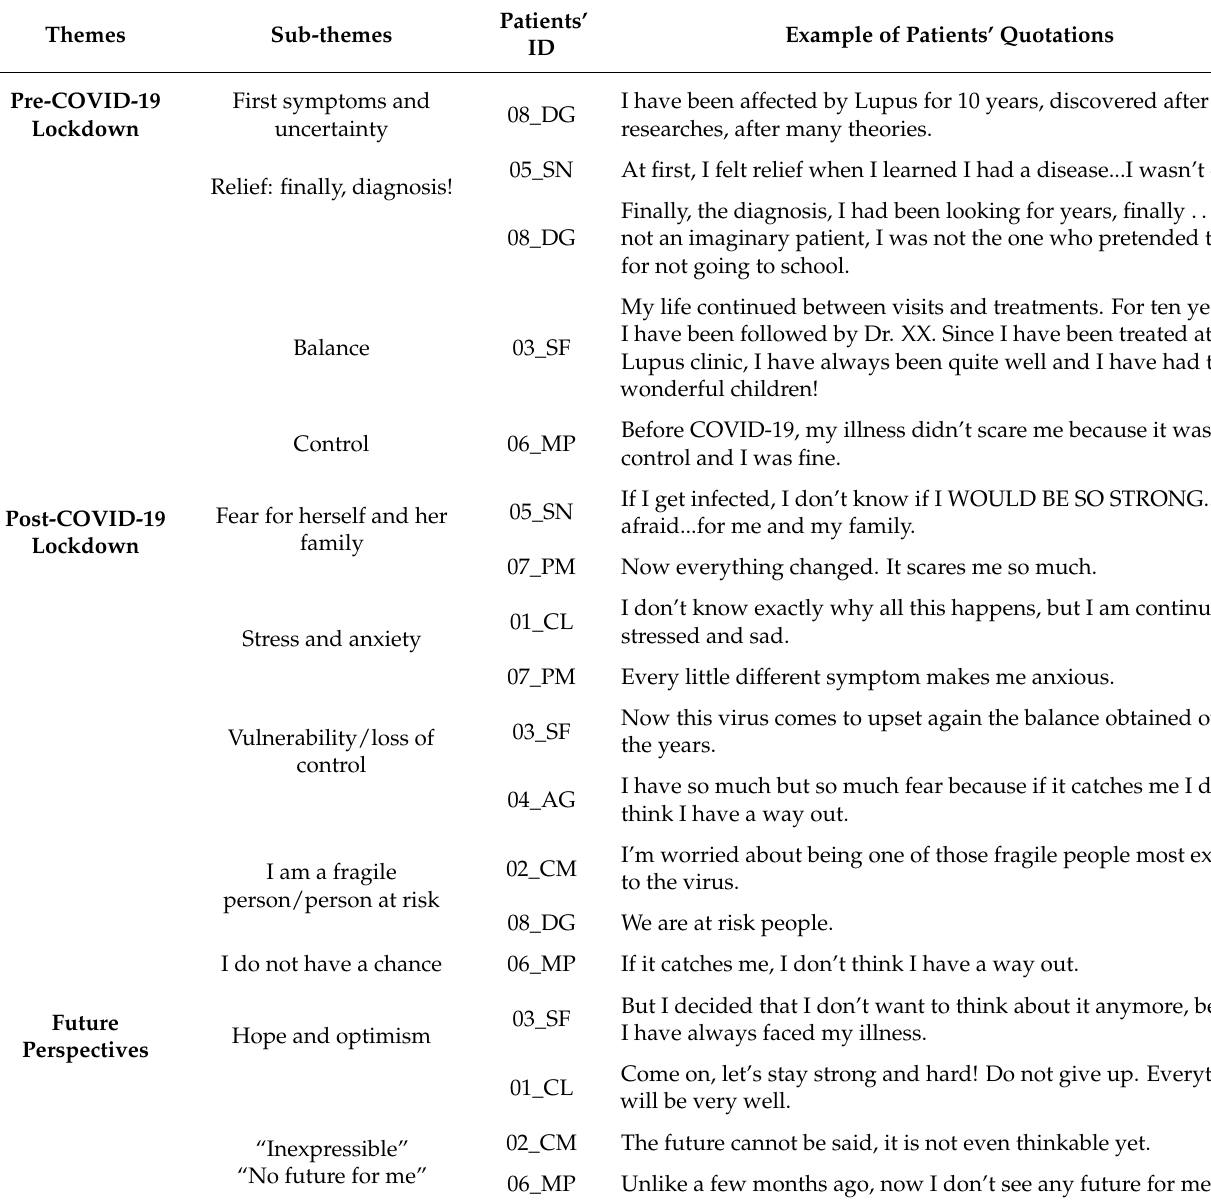
Table 2. Themes and sub-themes identified from patients’ narratives with related